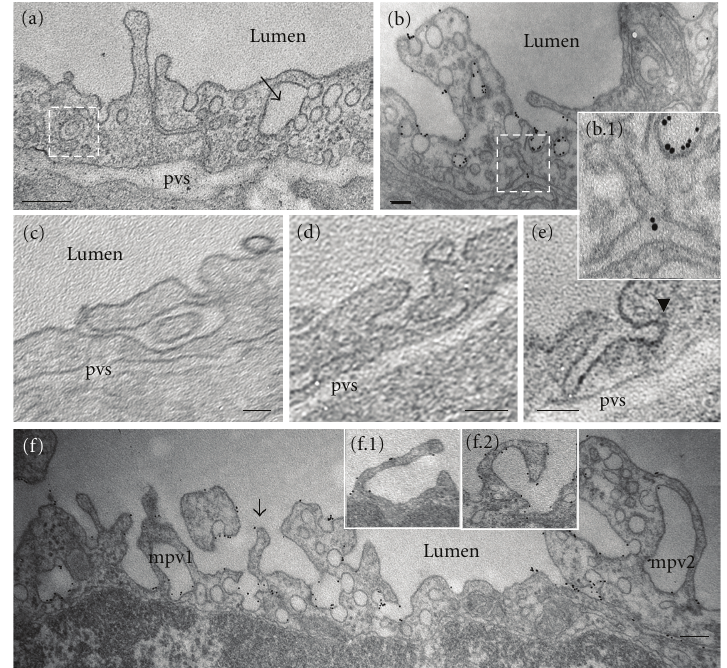
Figure 6: Chronic inhibition of ITSN-1s expression augments the activation of alternative endocytic/transcytotic pathways. (a–e) tubu- lovesicular EM images of membranous rings with diameters between 100 nm to 400 nm, (a, c), free in the cytosol or open to the lumen and tubules (b, d, e), some of them branching or discharging tracer in the perivascular space, (b, boxed structure, and inset), and enlarged endocytic structures, many of them fused with typical caveolae (a). Note the tubular structures are connected to the plasma membrane and displaying at their cytosolic termini caveolae (b1) or coated vesicles (e, arrowhead). Bars: 100 nm (b, c, d); 250nm (a); 75 nm (e); (f) membrane ru ffl es (f, arrow, insets f.1, f.2) and large macropinocytic vesicles (mpv1, mpv2) labeled by tracer particles. Bar: 150 nm.